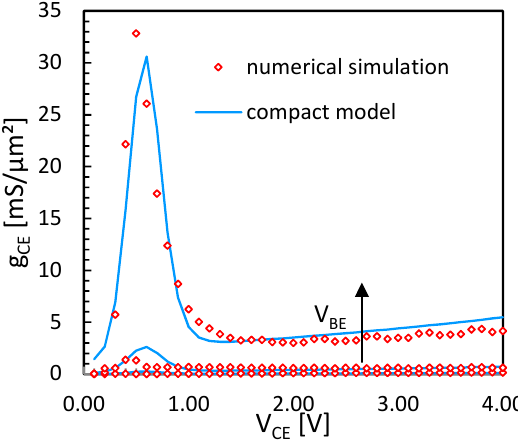
Figure 7. I CE versus V CE curves for different V BE values (0.75, 1, 1.25 V), numerical simulation and compact model simulation.